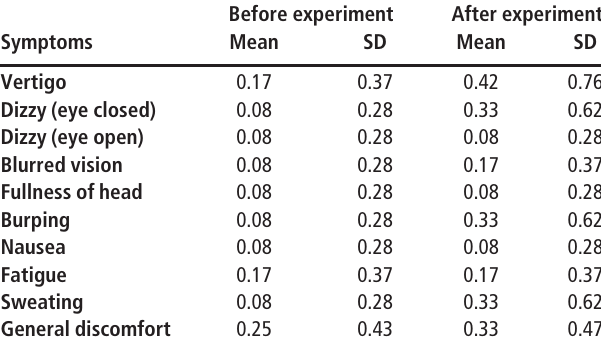
Table 5 Results of the SSQ survey